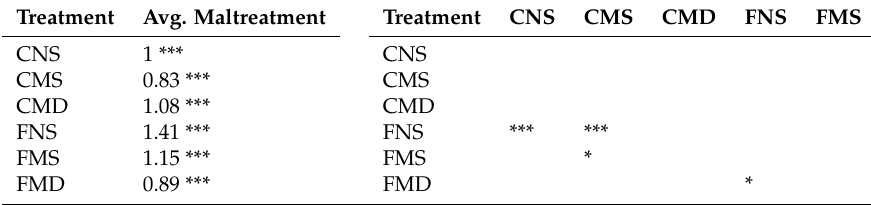
Table A11. Absolute deviation from optimal treatment of Type M Patients across experimental conditions.